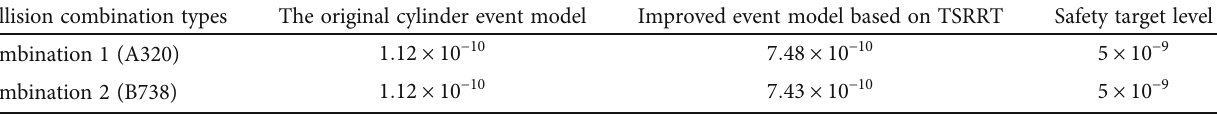
Table 4: Collision risk assessment